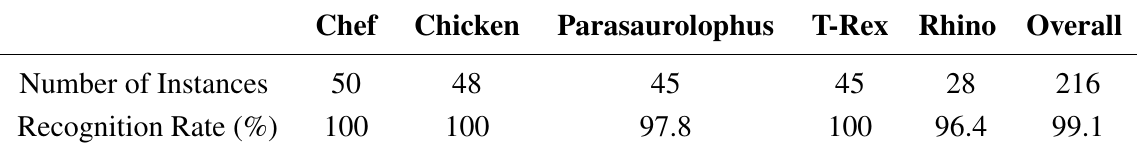
Table 1. Recognition rate of each object on the UWA